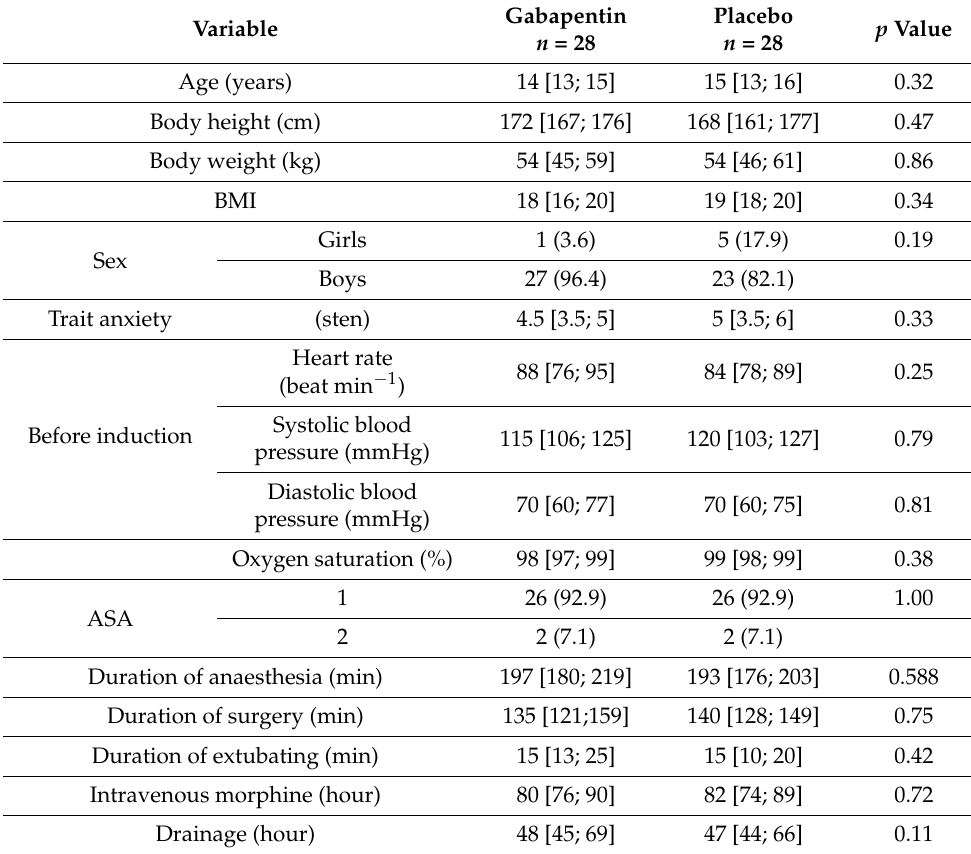
Table 1. Demographic and clinical data in the gabapentin and placebo